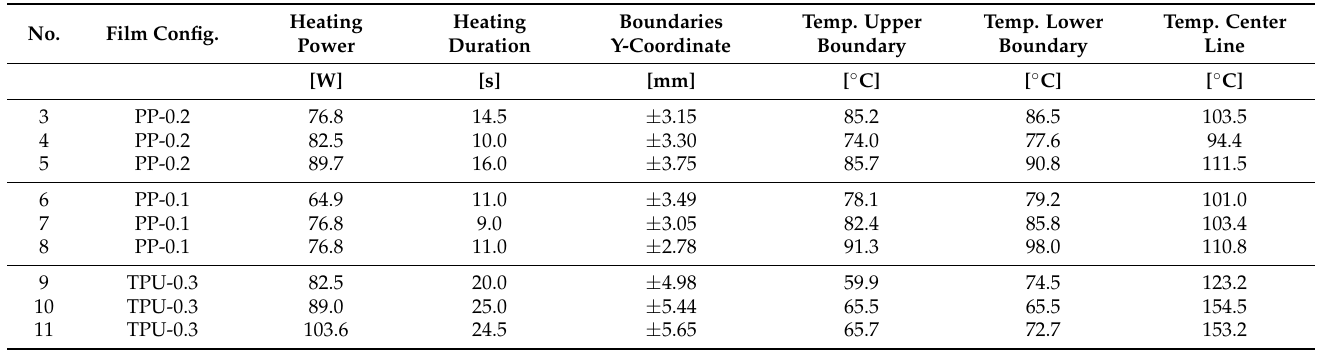
Table 3. Average temperature at the boundaries and at the center line of the hot bending area for a selection of tests.